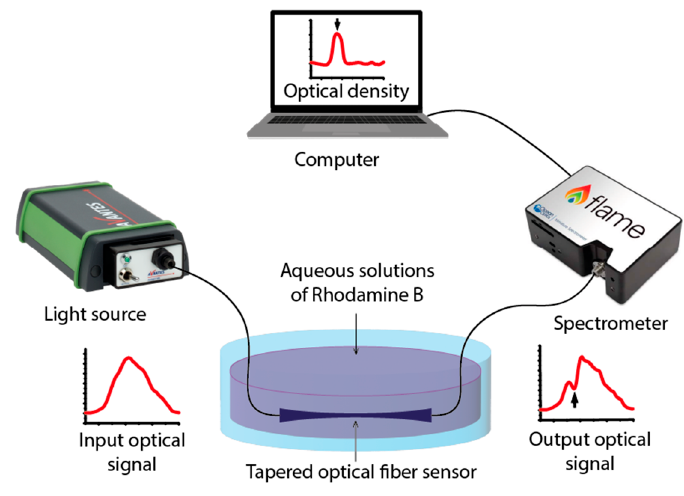
Figure 2. The scheme of the experimental setup.